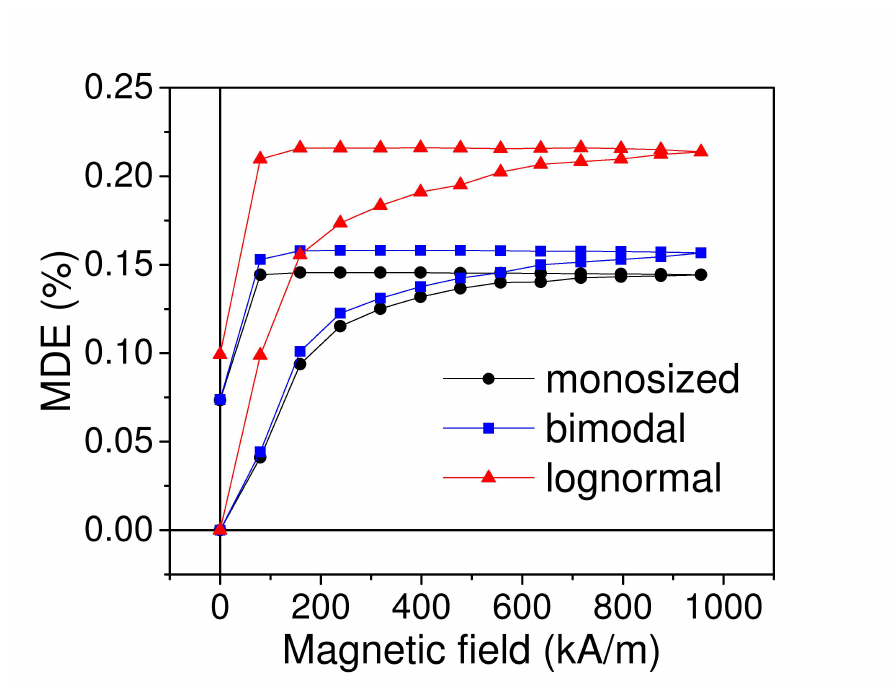
Figure 9. Simulated field dependence of magnetodielectric effect (MDE) for three different types of size distribution. Volume concentration of magnetic particles is 25%; magnetic field is perpendicular to the capacitor